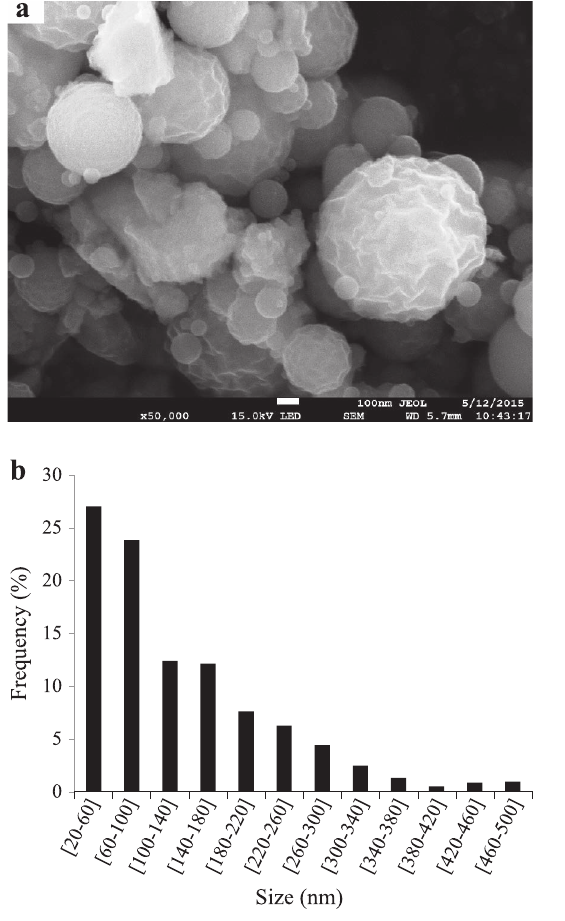
Fig. 11 Surface properties of the synthesized hematite: adsorption-desorption curves (a) and pore size distri- bution (b)